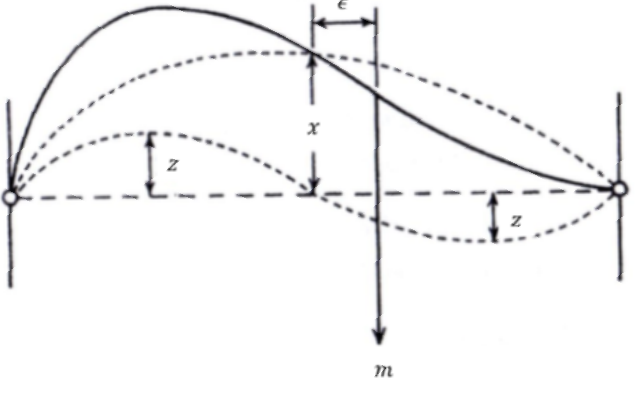
Figure 6. Compressed